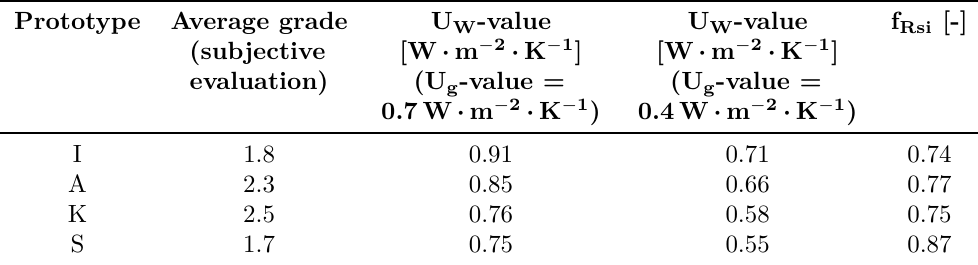
-values, and f -values of the different w Rsi